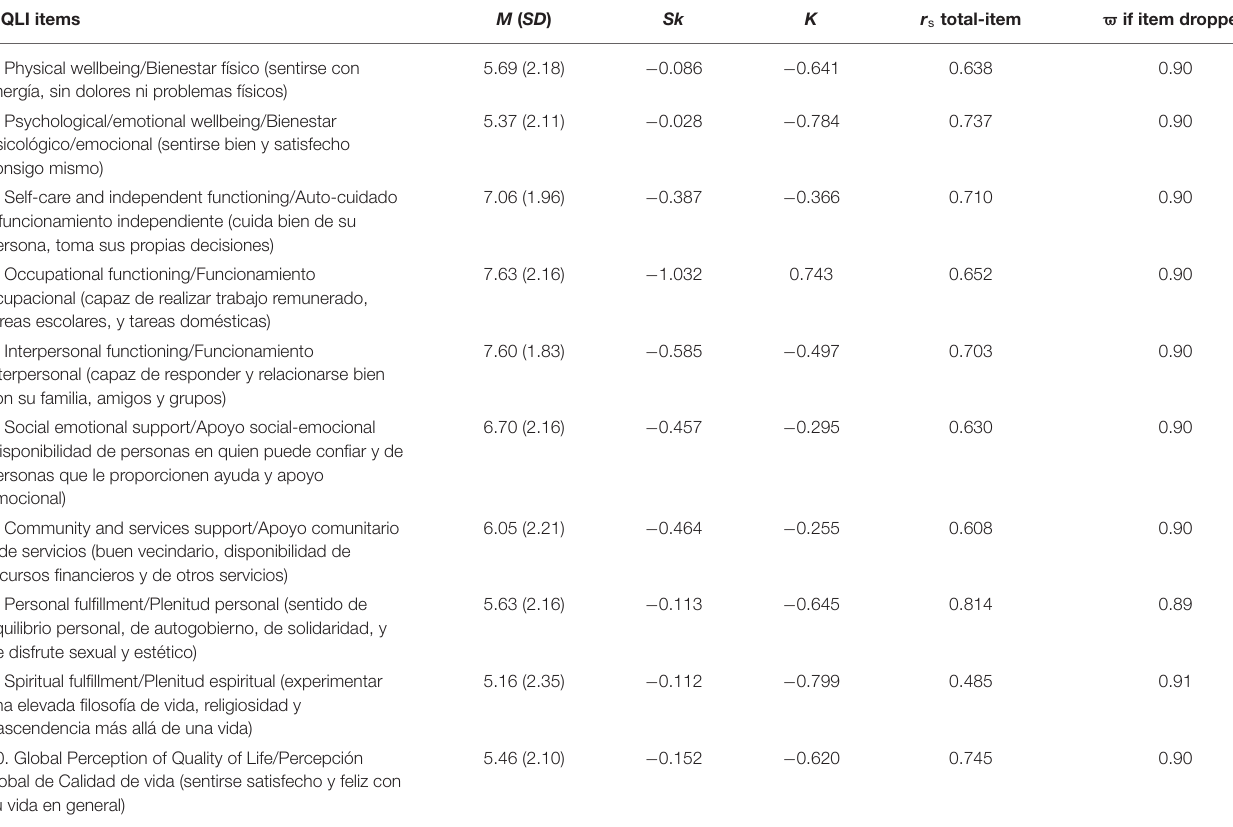
TABLE 4 | Descriptive statistics, correlations of the MQLI, and ̟ if item is dropped from the MQLI (women’s subsample). MQLI